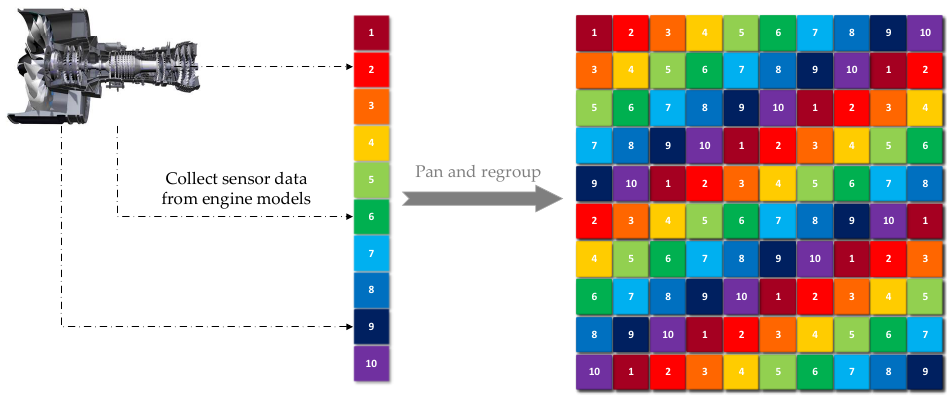
Figure 7. Expansion and recombination of sensor data.